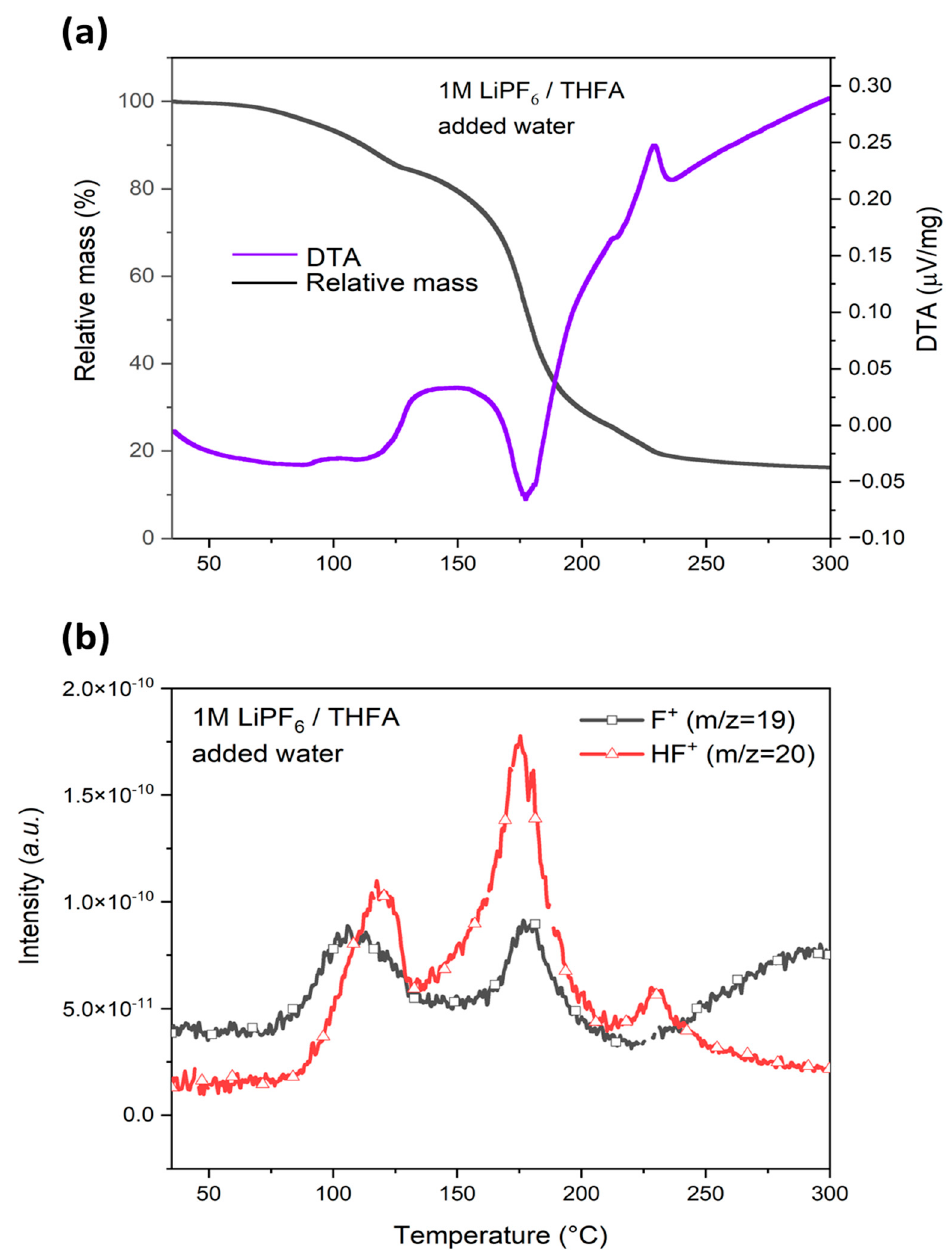
Figure 6. ( a ) TG/DTA curves of HF generation temperature in 1 M LiPF 6 /THFA electrolyte solution with added water, and ( b ) the simultaneous F + and HF + identification using MS.